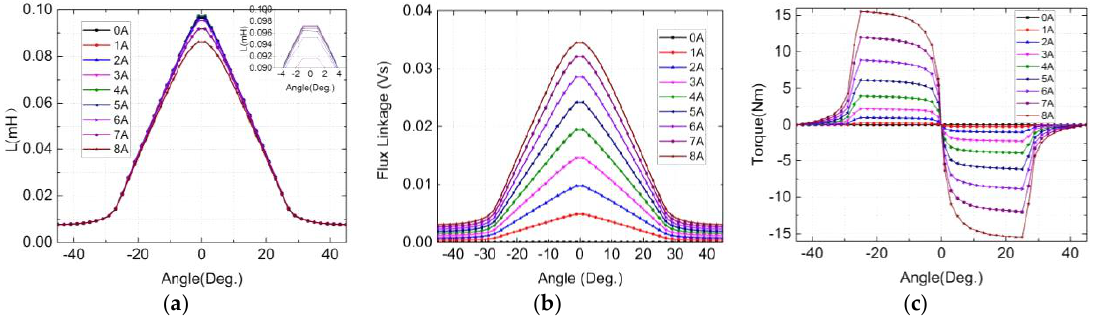
Figure 2. The phase inductance, the flux linkage profiles and the torque characteristics of the studied SRM: ( a ) inductance profiles; ( b ) flux linkage profiles; ( c ) torque profiles. Appl. Sci. 2018 , 8 , x FOR PEER REVIEW